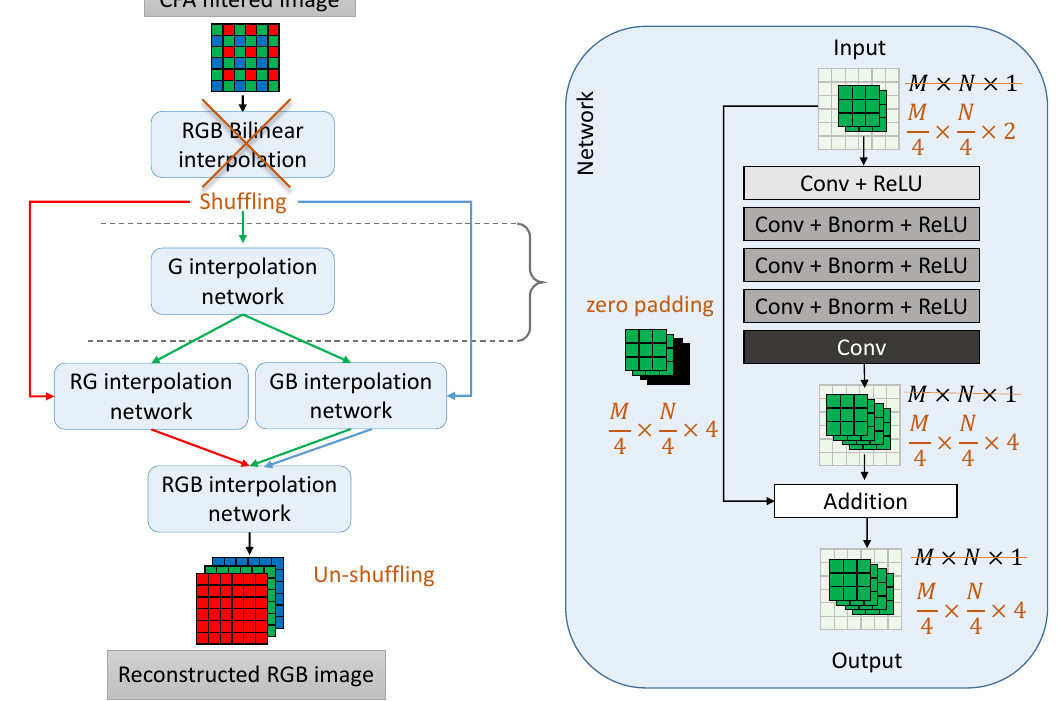
Figure 3. Flowchart of CDMNet and our modifications. The orange color represents locations where we modified the original algorithm to make it agnostic of any CFA pattern: no bilinear demosaicing, pixel shuffling and working in a lower spatial resolution with fixed downscaling factor of 4 ×